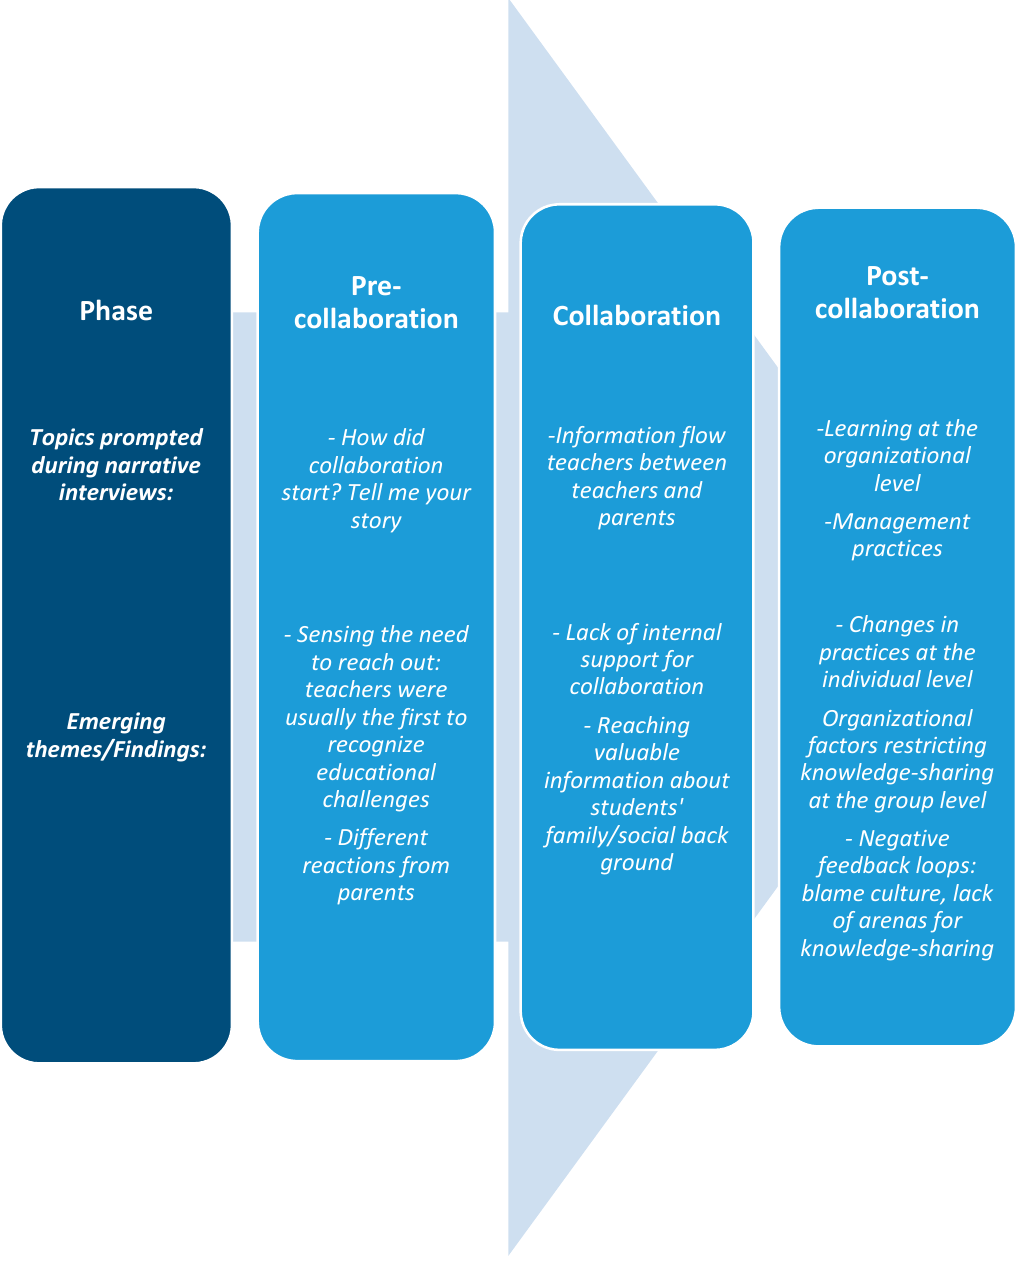
Figure 2. Temporal presentation of finding in the three phases of narratives.